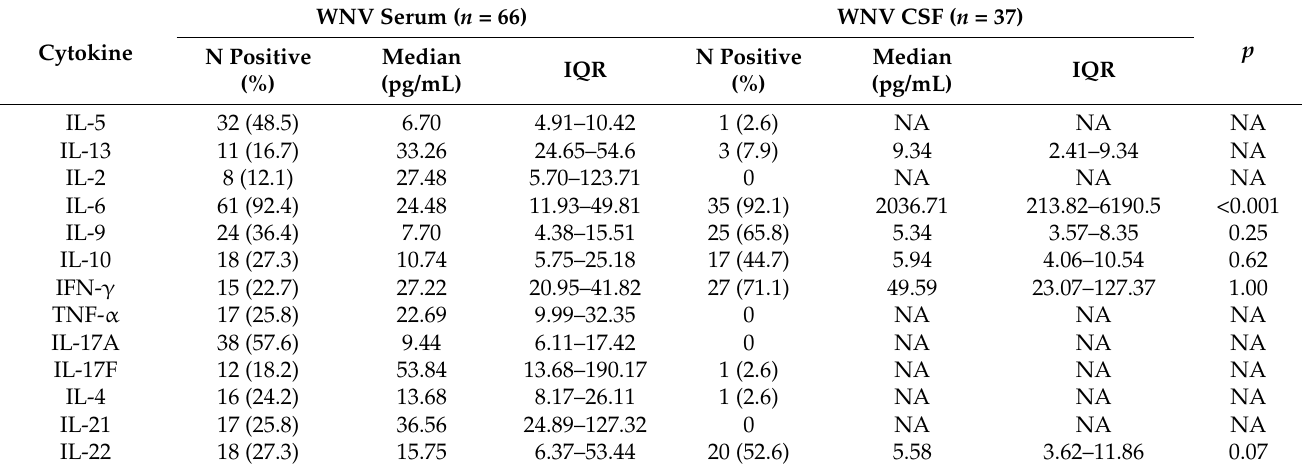
Table 4. Cytokine levels in serum and CSF samples of patients with WNV infection. WNV Serum ( n = Cytokine